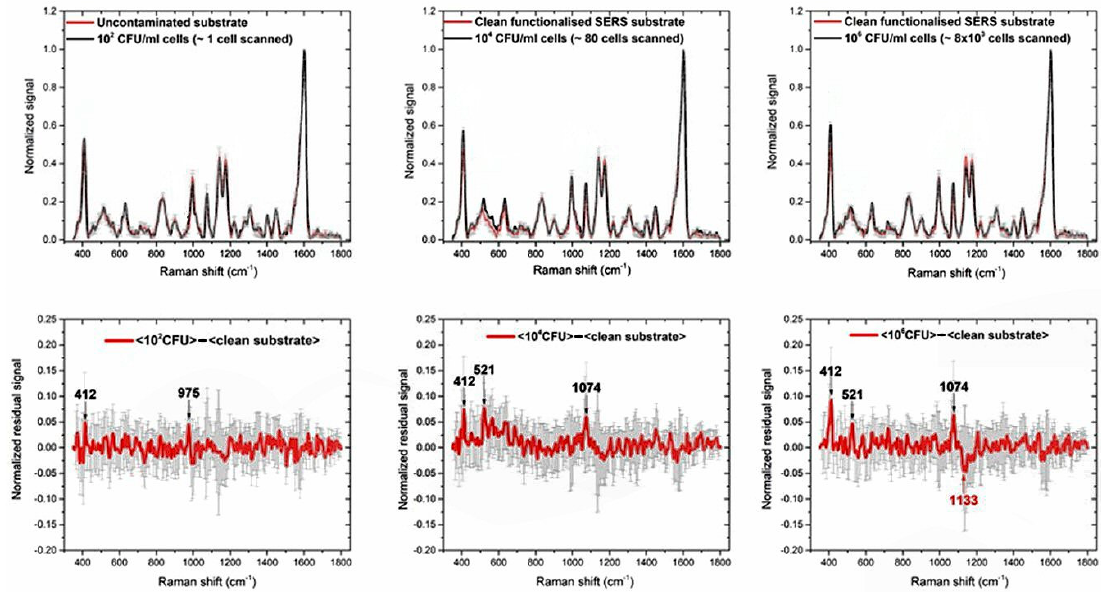
Figure 3. ( Top ) Mean SERS spectra of the contaminated substrate (black lines) with (from left to right) 10 2 CFU/mL, 10 4 CFU/mL, 10 6 CFU/mL Bt cells. The red spectrum in each graph is the mean SERS spectrum of the functionalized substrate before inoculation with Bt (control, clean substrate). ( Bottom ) Residual signals obtained by subtracting the spectrum of the contaminated substrates (black lines) from the one of the clean substrate (red lines). The more remarkable spectral differences are labelled in black, if the residual signal is positive or red, if negative. Error bars are reported as grey vertical bars in each graph.